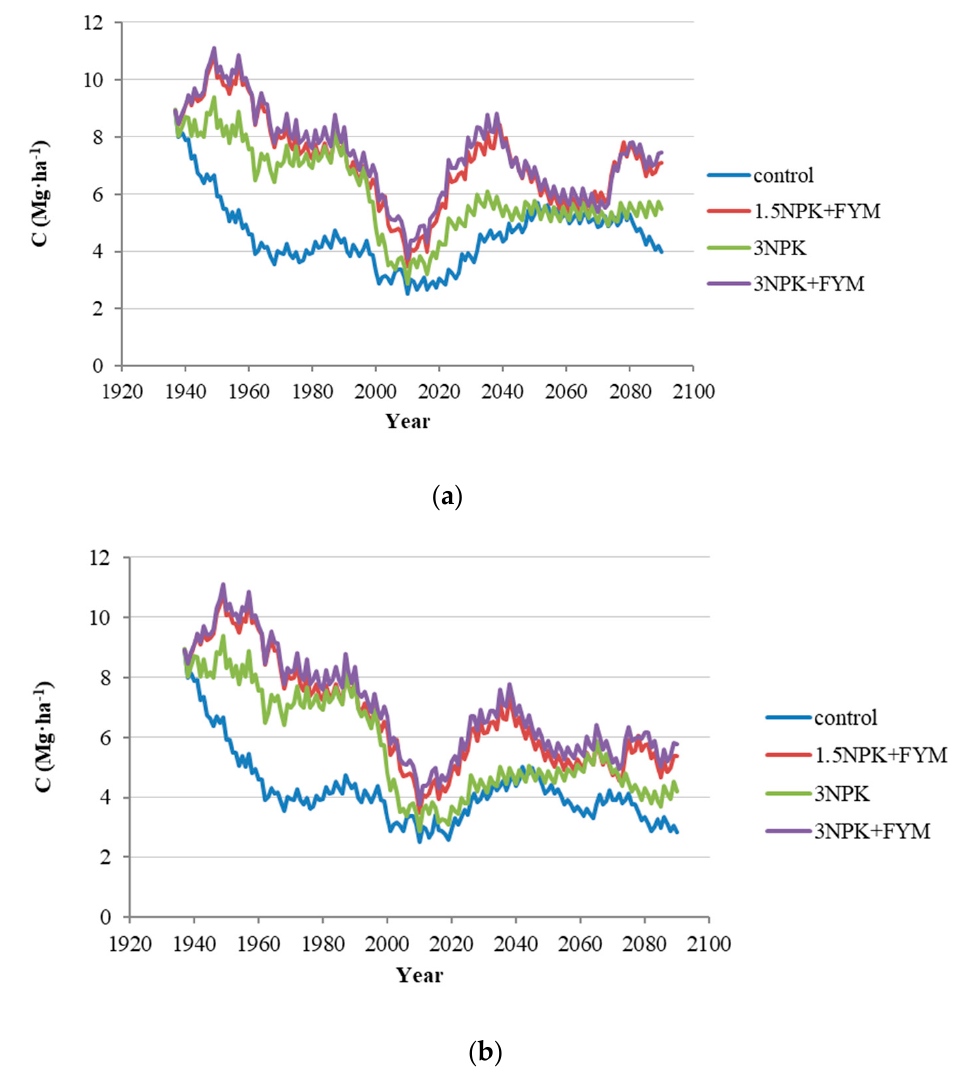
Figure 3. Simulated annual dynamics of C in the resistant plant material (RPM) pool in the DAOS 3 experiment: ( a ) RCP4.5 and ( b ) RCP8.5.